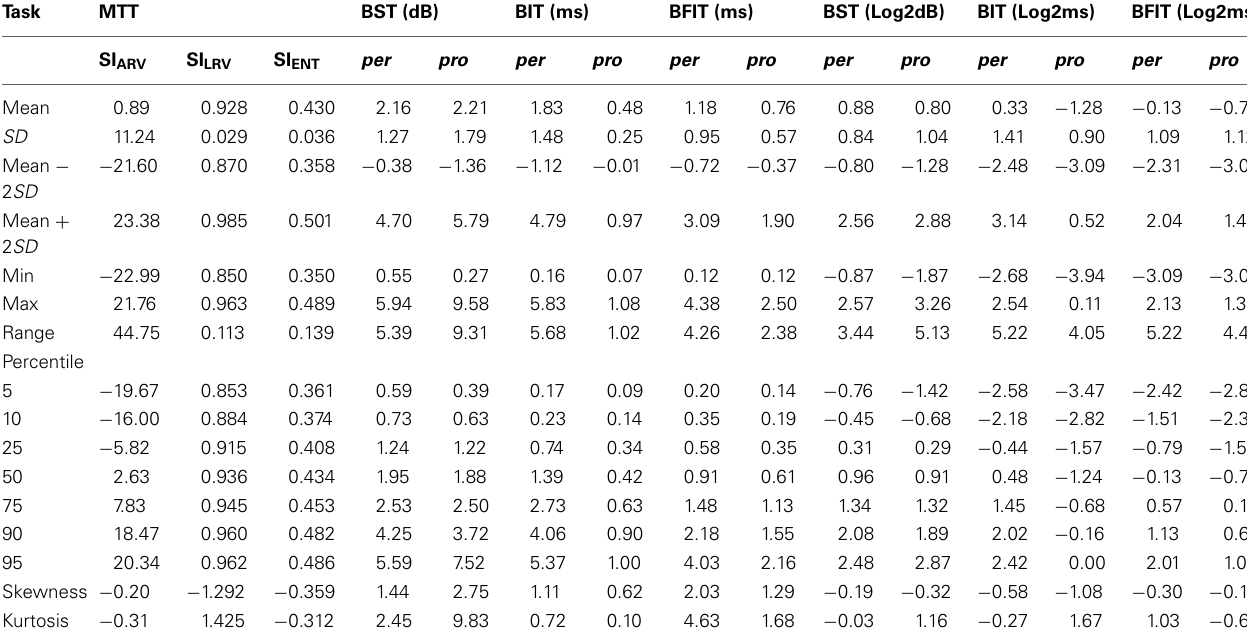
Table 1 | Scores in the Harvard Beat Assessment Test (H-BAT) ( n = 30). Task